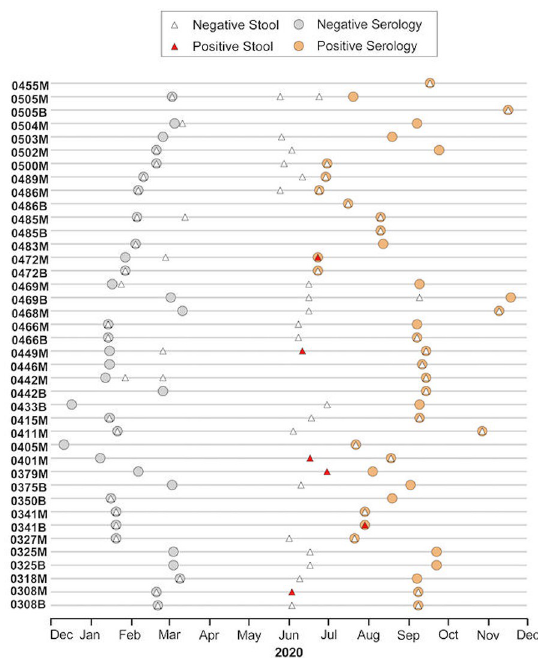
Fig 3. SARS-CoV-2 serology and stool viral RNA results over calendar time. Results of SARS-CoV-2 serology and quantitative real-time PCR testing of stool samples from Linda Kizazi participants that first tested seropositive and had � 1 available stool sample collected between May 1-December 31, 2020. Anonymized ID numbers on y-axis for mothers (M) and infants (B). Grey circles indicate date of last seronegative serology test and orange circles indicate date of first seropositive sample. White triangles represent SARS-CoV-2 RNA-negative and red triangles represent RNA-positive stool samples. Calendar time is on the x-axis.